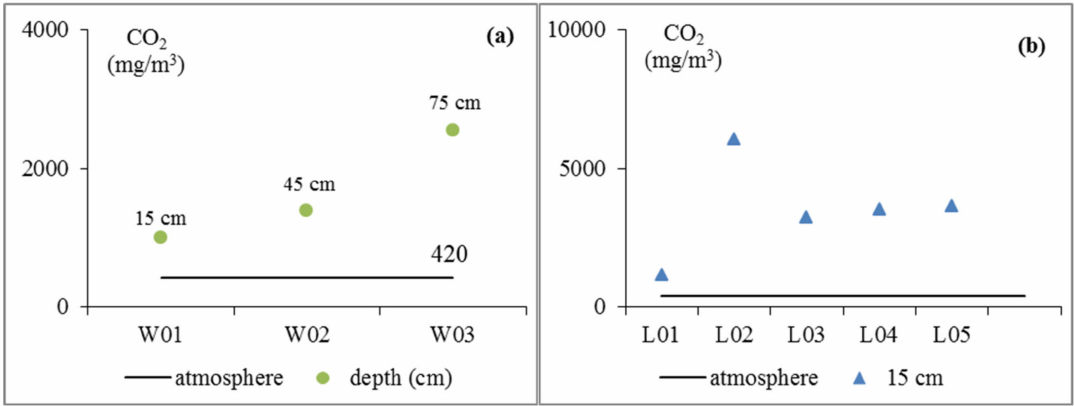
Figure 3. The change in soil CO 2 concentrations (the horizontal line shows the amount of CO 2 in the atmosphere. ( a ) shows the soil CO 2 concentration at di ff erent depths, and ( b ) shows the soil CO 2 concentration at 15 cm under di ff erent vegetation